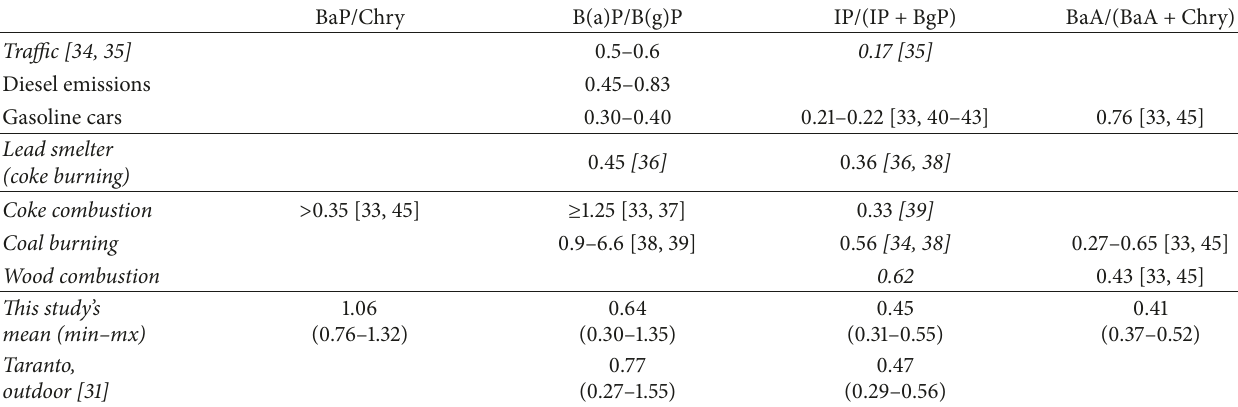
Table 2: DRs range determined in literature and in this study.